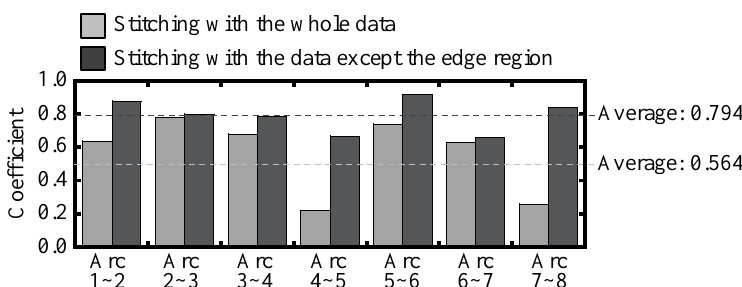
Figure 11. Cross-correlation coefficients observed in the stitching operation.